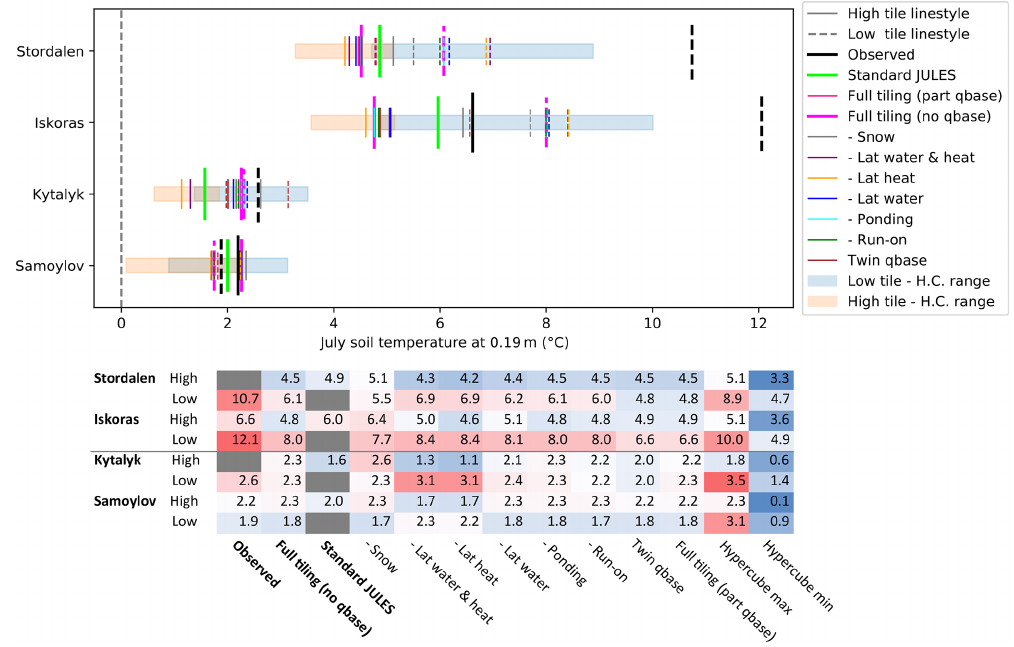
Figure 12. Average July soil temperature (2000–2016) at 0.19m for the subtractive process-switching runs, where model processes are switched off individually starting from the base configuration of full tiling (no qbase) (thick pink). Solid lines show the high tile and dashed lines the low tile. The range across the Latin hypercube sampling runs (H.C. range) are shown by the boxes. The depths of the observations are as follows: for Samoylov, the rim was at 0.21m, and the centre was at 0.2m; for Kytalyk the rim was at 0.15m, and the centre was at 0.25m; for Iškoras, the palsa and mire were at 0.2m; and for Stordalen the mire was at